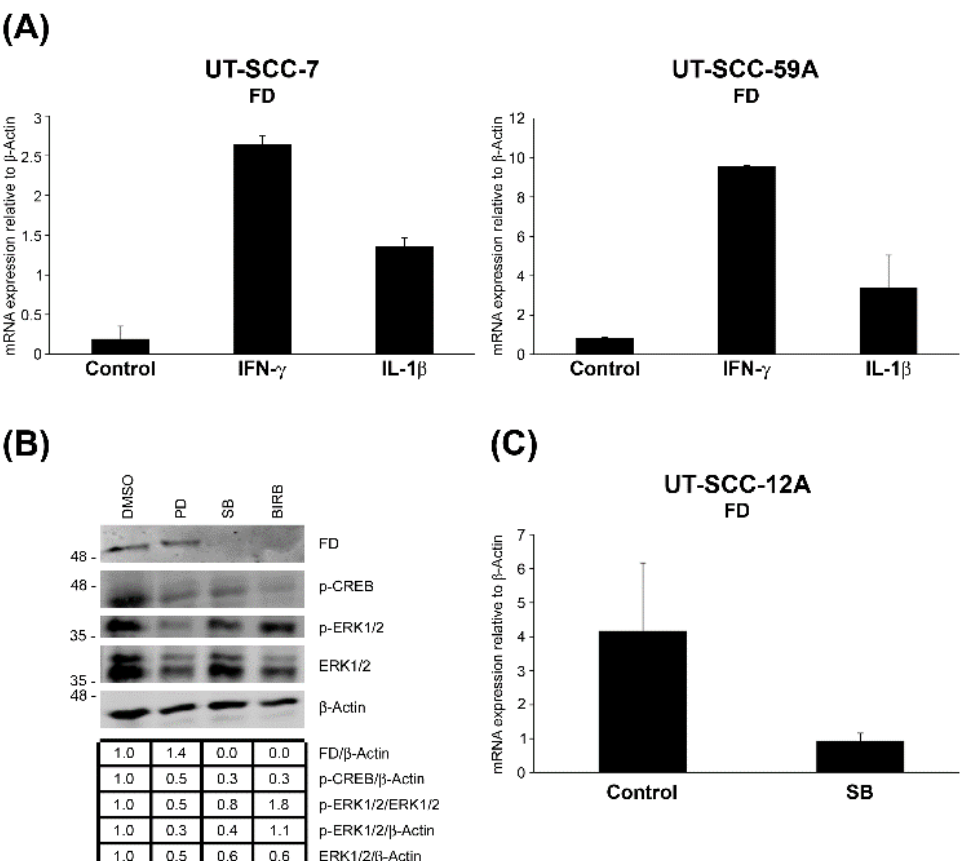
Figure 3. Up-regulation of FD expression in cSCC cells by interferon- γ and interleukin-1 β , and p38 MAPK signaling pathway. ( A ), cSCC cells in culture were treated with interferon- γ (IFN- γ ; 100 IU/mL) or interleukin-1 β (IL-1 β ; 10 ng/mL) for 24 h. The expression levels of FD mRNA were ana- lyzed by RT-qPCR, and the levels were corrected for β -Actin mRNA levels in the same samples. Mean ± S.D. is shown. ( B ), cSCC cells (UT-SCC-12A) were treated with MEK1/2 inhibitor (PD98059; 30 μ M) or p38 inhibitor specific for p38 α / β (SB203580; 10 ÌM) or the inhibitor of all p38 isoforms α , β , γ and δ (BIRB796; 10 μ M) for 24 h. The conditioned media were analyzed for levels of FD by Western blotting. Cell lysates were analyzed for levels of phosphorylated CREB (p-CREB), phos- phorylated ERK1/2 (p-ERK1/2) and ERK1/2 to verify the proper effects of SB203580, BIRB and PD98059, respectively. β -actin was used as a sample and loading control. Migration of molecular weight markers in kDa is shown on the left. The uncropped immunoblot images can be found in Figure S2. ( C ), The levels of FD mRNA in cSCC cells in culture (UT-SCC-12A) treated with SB203580 were determined using RT-qPCR and corrected for β -Actin mRNA levels in the same samples. Mean ± S.D. is shown.